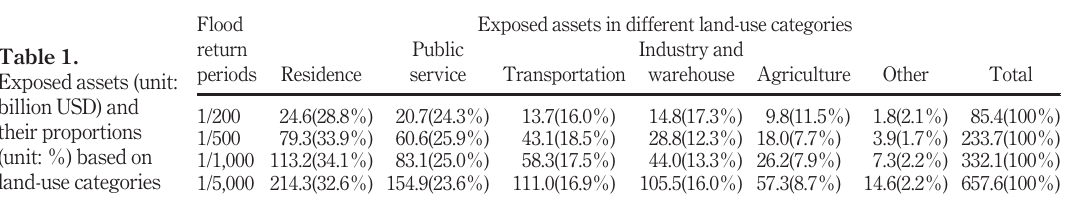
Flood return periods